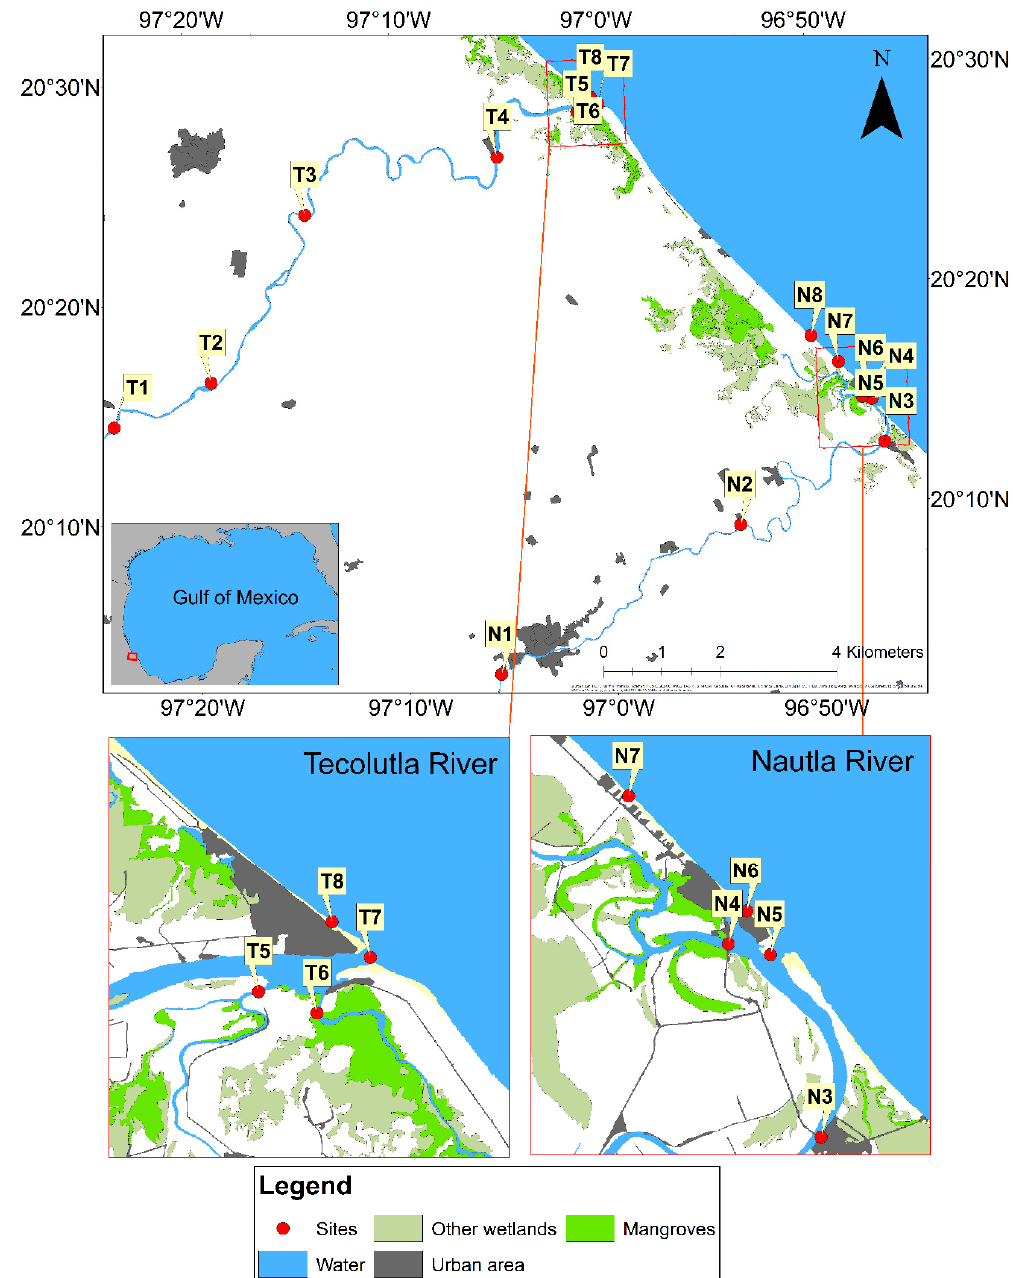
Figure 1. Study area with monitoring sites.